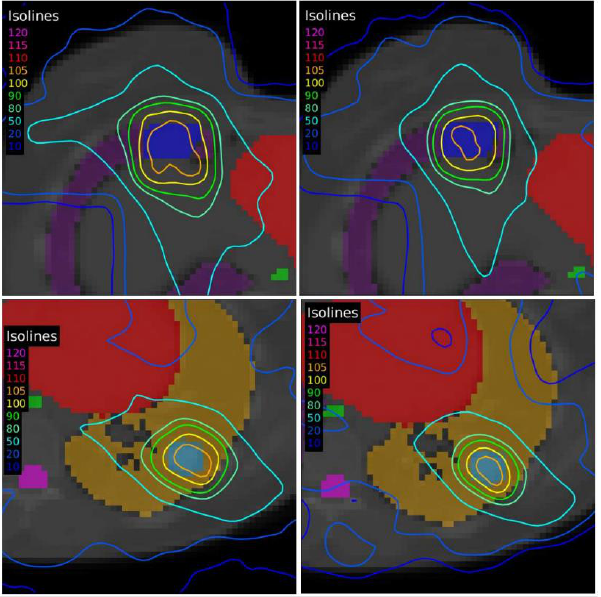
Figure 9. Dose distribution for Case 3 by applying the dose-painting technique under EARL1 ( left )